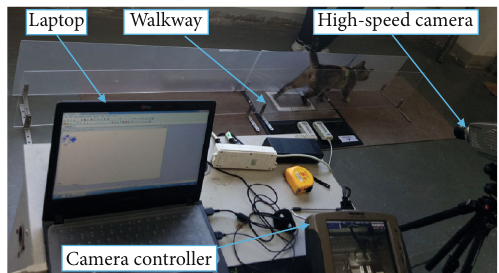
Figure 1: Test setup for force measurement.